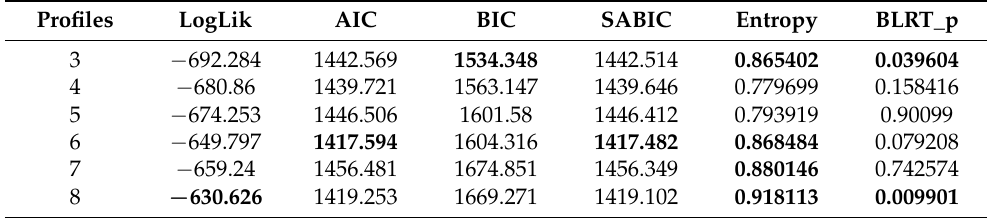
Table 3. Fit indices for the profile enumeration.